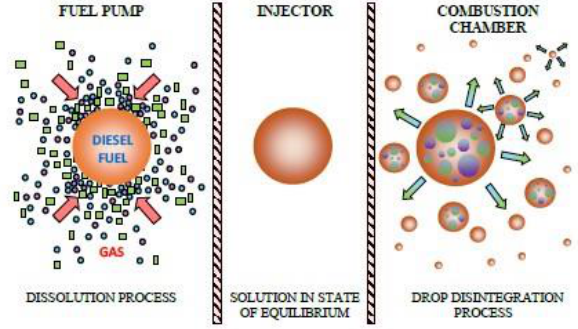
Fig. 1. The effect of gas desorption from the solution with the nucleation of the gas bubbles – illustration